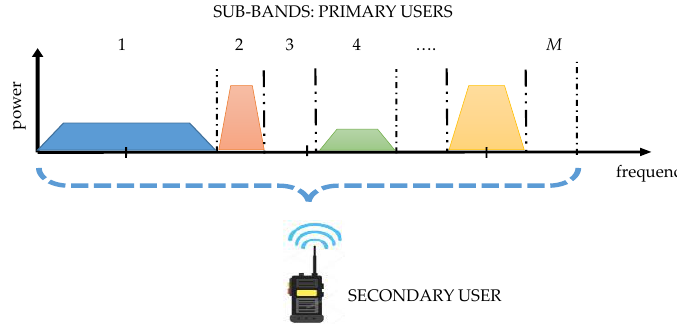
Figure 1. The multiband spectrum sensing concept in cognitive radio (CR) presented in [8].